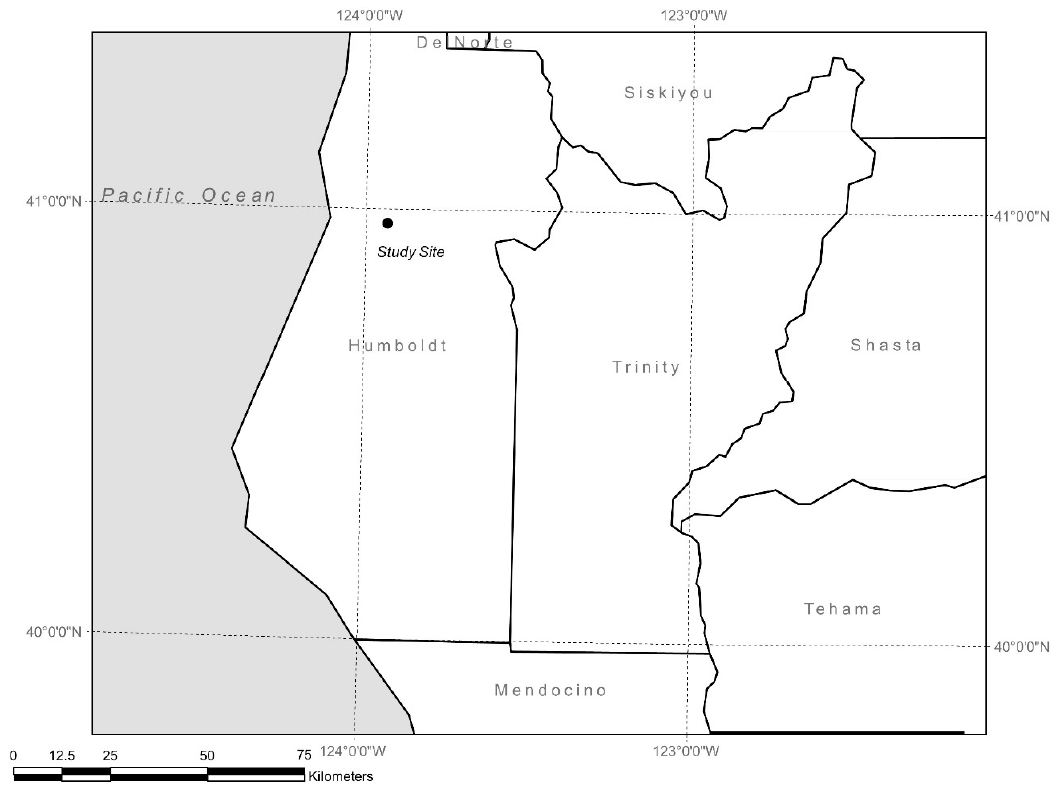
Figure 1. Study area for the integrated centralized biomass recovery operation and biomass conversion technology model in Humboldt County, California.